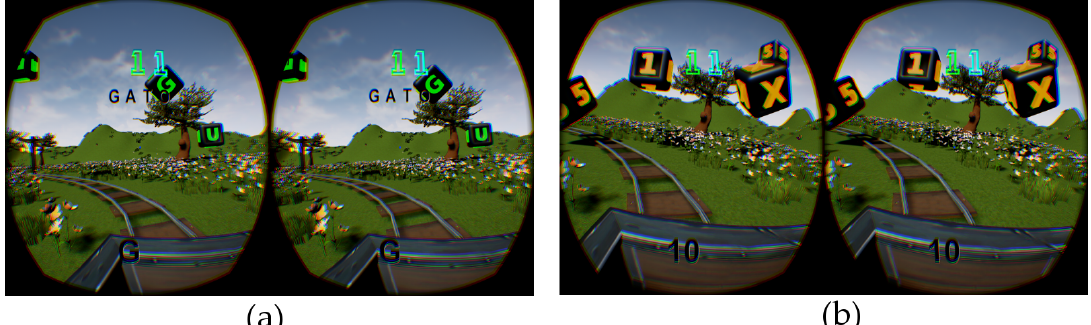
Figure 6. The images show the patients’ view while executing activities. ( a ) The Forming Word activity shows in the patient’s interface the word—so the patient will know the letters necessary to complete the task. ( b ) The Summation activity shows in the patient’s interface the final value to be